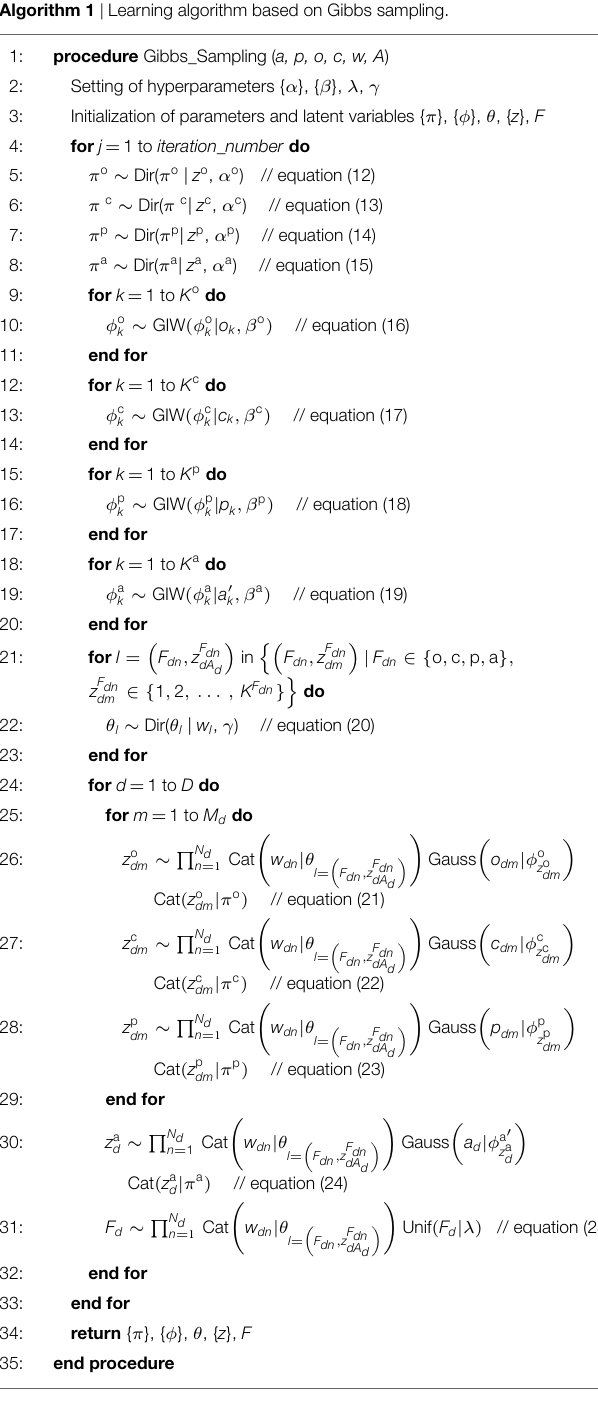
Algorithm 1 | Learning algorithm based on Gibbs